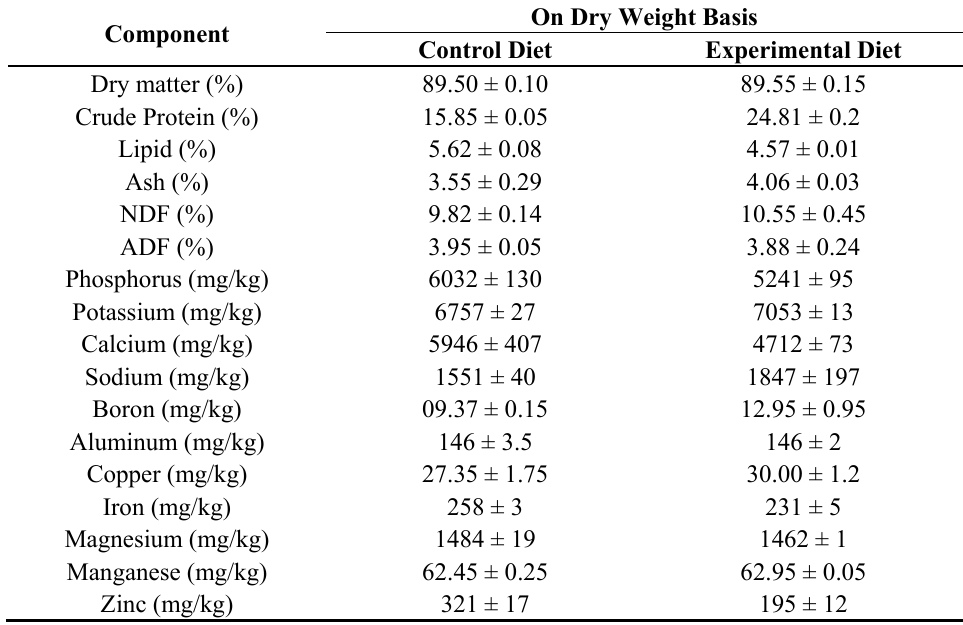
Table 1. Proximate composition of control and experimental